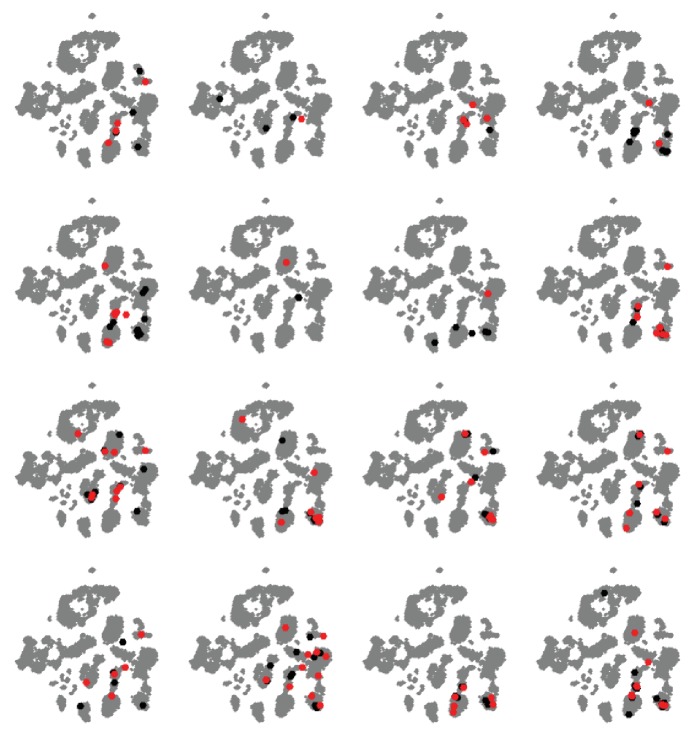
Transcriptomic diversity of individual translaminar clones, related to Figure 3.t-SNE plots for each Patch-seq experiment (n = 16) showing clonally related cells in red and unrelated cells in black, projected onto the reference atlas in gray, from Tasic et al. (2018).